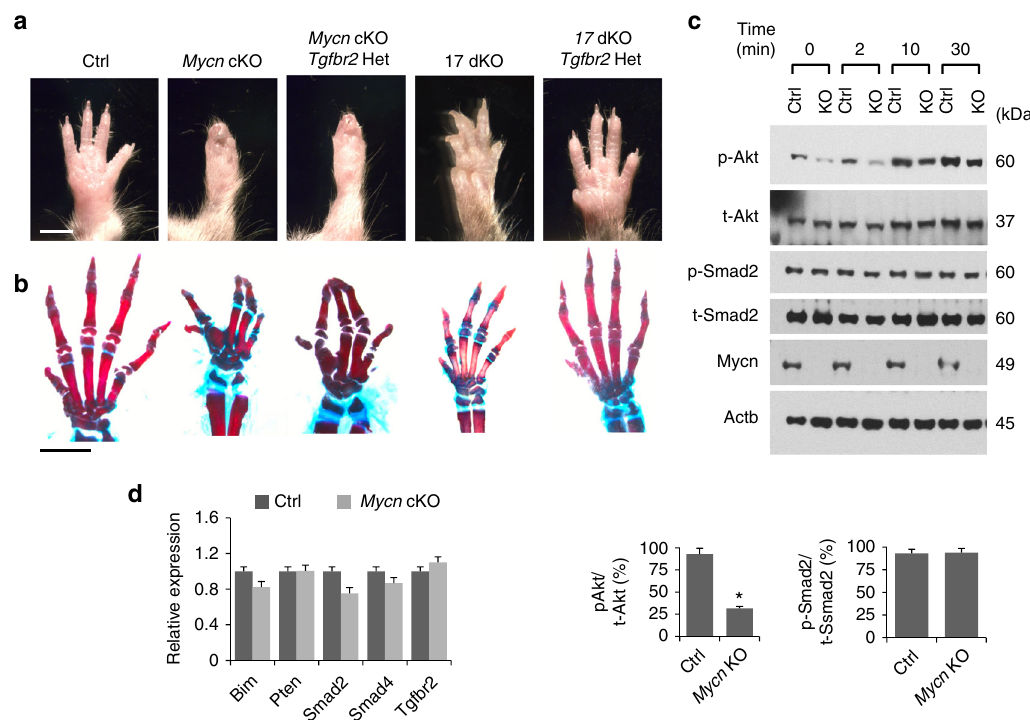
Fig. 5 Distinct mechanisms in Feingold syndrome mouse models. a Forelimbs of mice with indicated genotypes at postnatal day 16. Wildtype control (Ctrl), Mycn conditional Knockout ( Prx1-Cre:Mycn fl / fl , Mycn cKO), Mycn cKO in which one allele of Tgfbr2 is deleted ( Prx1-Cre:Mycn fl / fl :Tgfbr2 fl / + , Mycn cKO :Tgfbr2 Het), Mir17-92 and Mir106b-25 doubly conditional knockout ( Prx1-Cre:Mir17-92 fl / fl :Mir106b-25 − / − , 17 dKO), and 17 dKO in which one allele of Tgfbr2 is deleted ( Prx1-Cre:Mir17-92 fl / fl :Mir106b-25 − / − :Tgfbr2 fl / + , 17 dKO: Tgfbr2 Het). Unlike 17 dKO mice, the digit abnormalities of Mycn cKO mutants are not rescued by Tgfbr2 heterozygous deletion. b Alizarin red and alcian blue staining of forelimbs of corresponding mice in a . Scale bars, 0.5 cm. More than three rescued mice per each model were analyzed to con fi rm the reproducibility. c Immunoblot analysis for indicated proteins upon treatment with 10% fetal bovine serum (FBS) at indicated time points (top panel). Primary mesenchymal fi broblasts from limb buds of E10.5 Mycn fl / fl embryos were transduced with adenoviruses expressing a Cre recombinase (KO) or a yellow fl uorescent protein (Ctrl) to delete Mycn in vitro. Cells were serum starved for 1 h before stimulation. The ef fi cient reduction in the Mycn protein level was con fi rmed. Levels of p-Akt (Thr308) and p-S6k are decreased in Mycn -de fi cient limb bud cells (KO). Quanti fi cation of p-Akt relative to total Akt (t-Akt) and p-Smad2 to total Smad2 (t-Smad2) at time 0 based on the western blot data (bottom panels) ( n = 3, * p < 0.05). d Relative expression of previously reported targets of miR-17-92 miRNAs in Mycn cKO limb bud mesenchymal cells isolated from embryos at age E10.5. Y axis, arbitrary